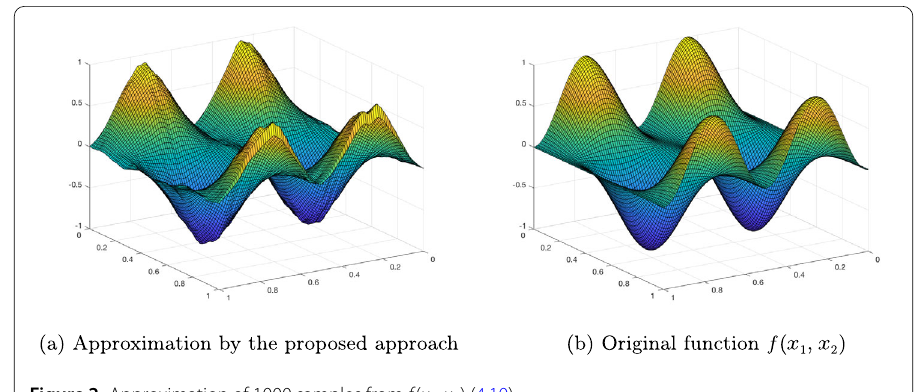
Figure 2 Approximation of 1000 samples from f ( x 1 , x 2 )